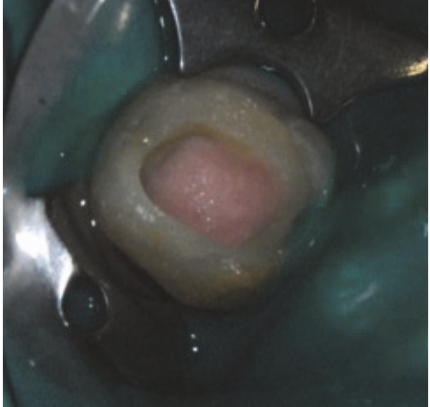
Figure 2: Endodontic filling with the antibacterial medication.